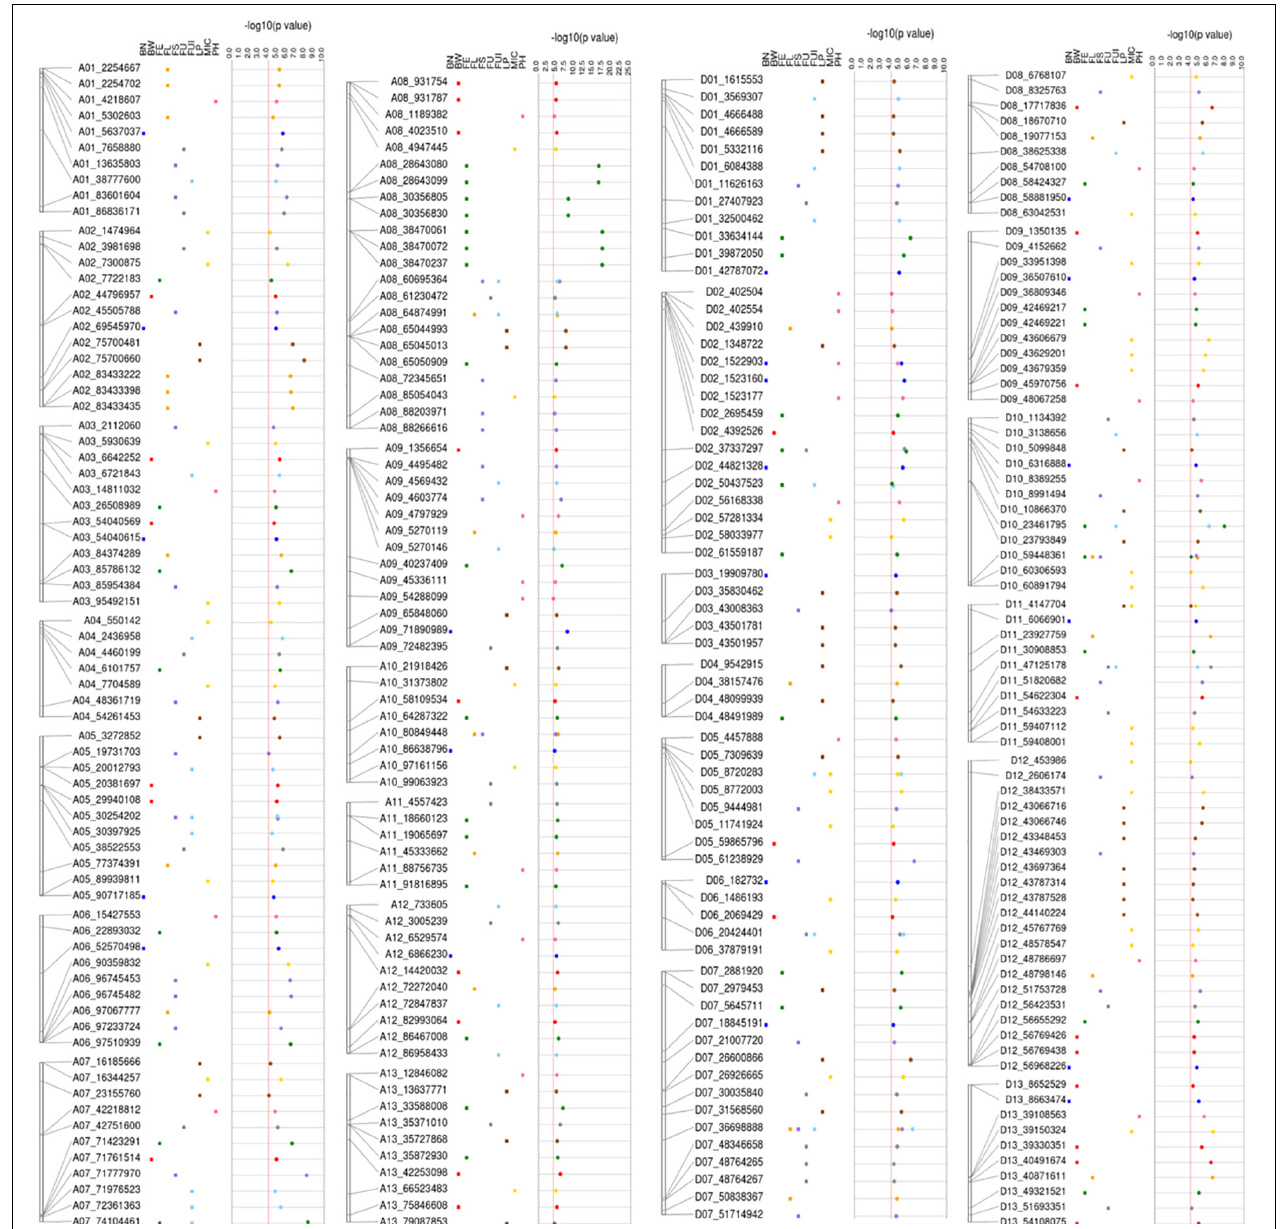
FIGURE 8 | Detailed view of significant SNPs related to five types of heterosis, F 1 , SCA and studied traits on 26 chromosomes with their physical positions